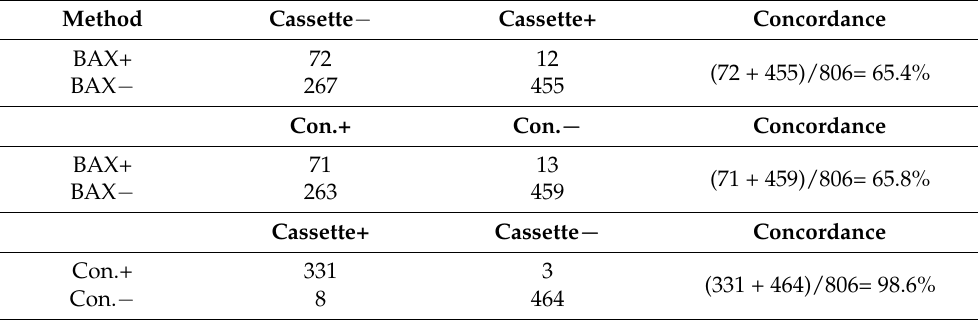
Table 2. Concordance between cassette PCR, conventional PCR (con.) and BAX